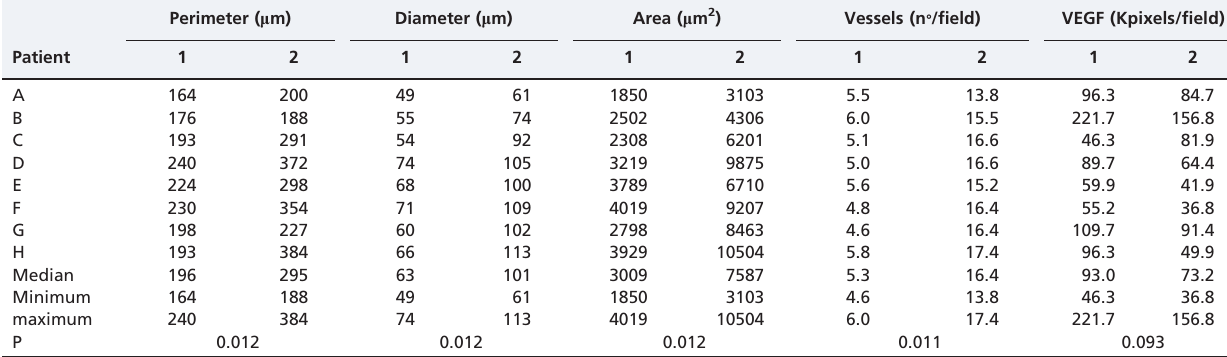
Table 2 - Morphometric measurements, vascular density and VEGF of the patients (n = 8).